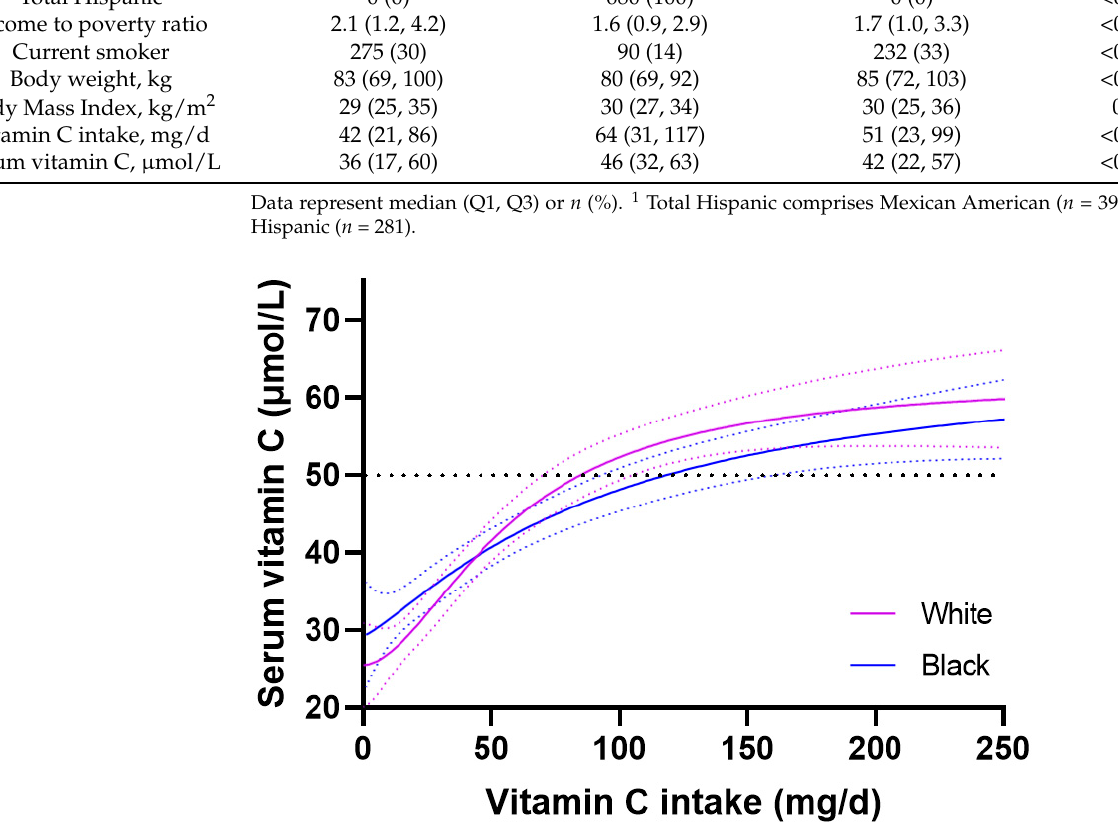
Figure 6. Vitamin C dose-response relationship relative to ethnicity. Non-Hispanic white ( n = 940), and non-Hispanic black ( n = 728). Sigmoidal (four parameter logistic) curves were fitted to the dose-concentration data with asymmetrical 95% confidence intervals indicated. Dashed line indicates 50 µ mol/L serum vitamin C which is considered